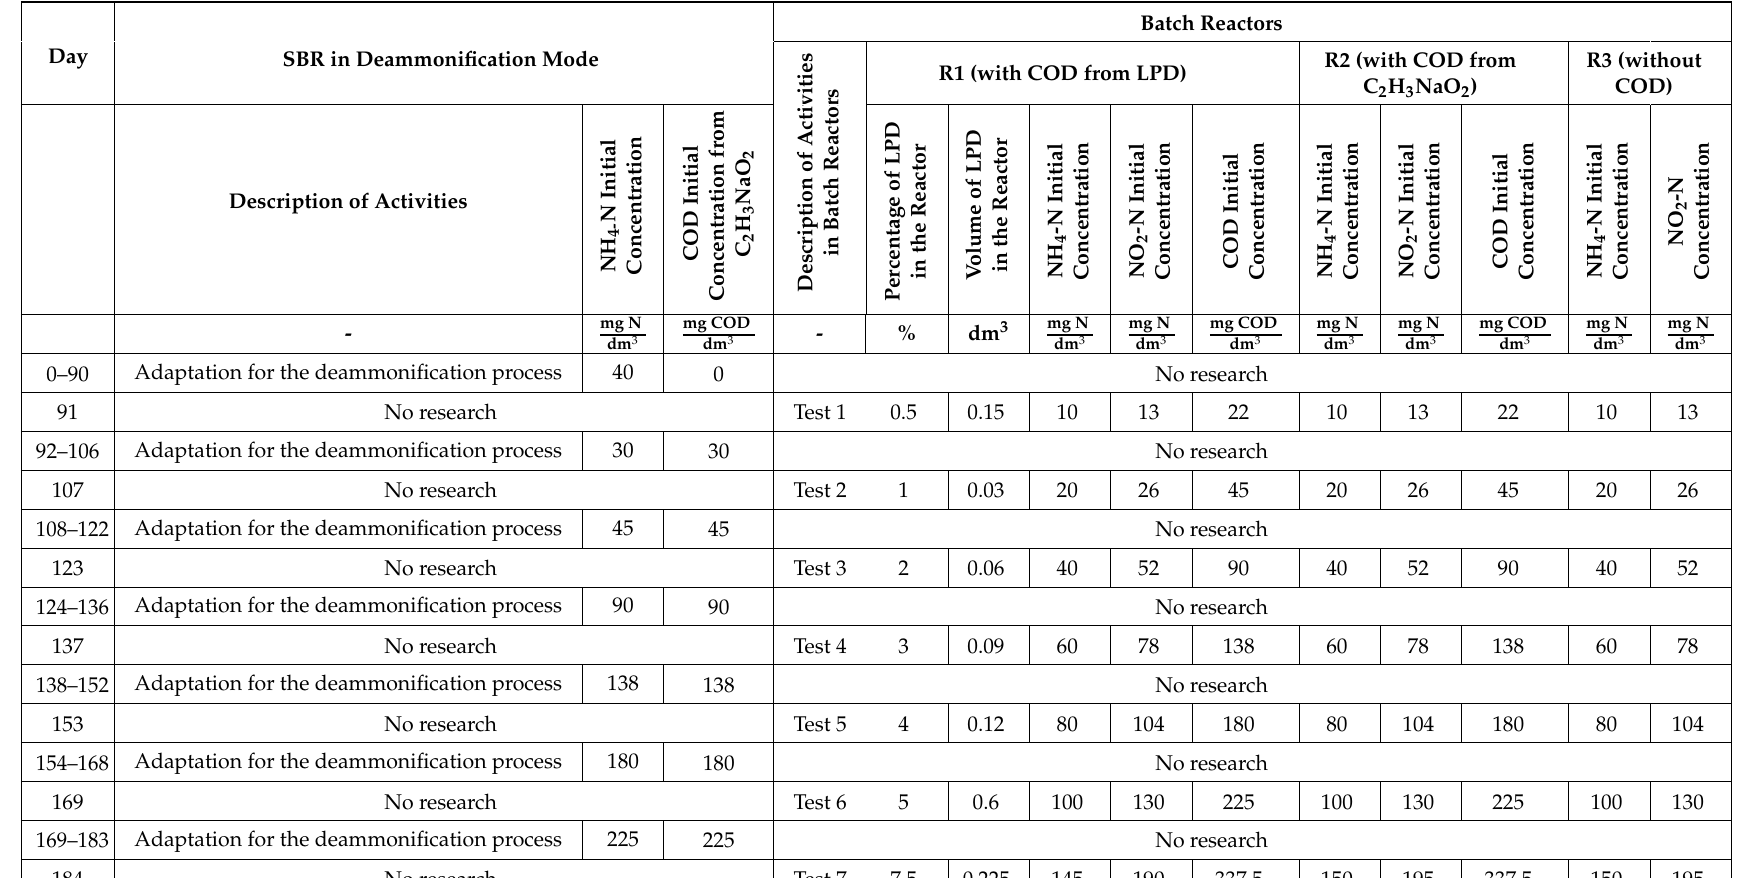
Table 1. Characteristics of